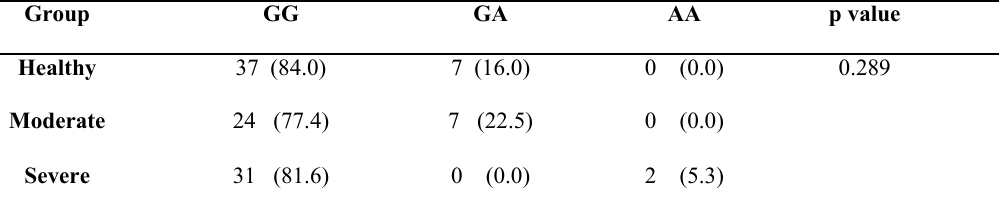
Table 2. Distribution of the TNF- α genotypes in the healthy group and in groups with moderate and severe chronic